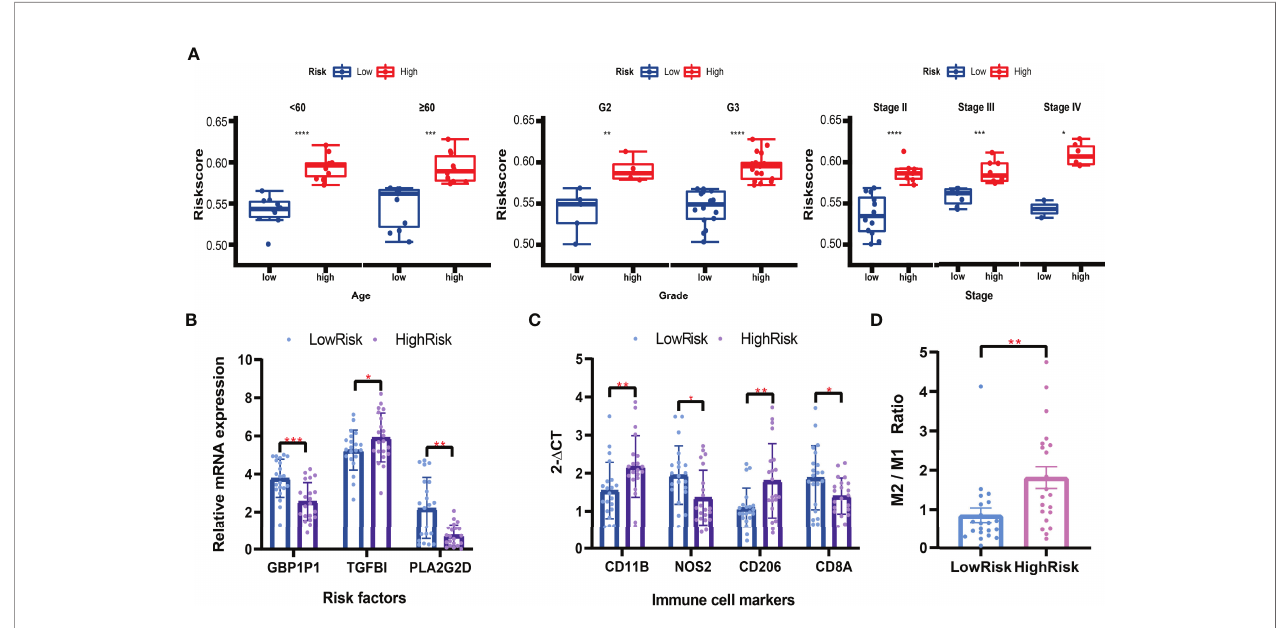
FIGURE 11 | Validation in clinical tissues by qRT-PCR. (A) Boxplots of the risk scores in subgroups (Aged ≥ 60, Age < 60, Grade 2, Grade 3, Stage II, Stage III, and Stage IV). Student ’ s t-test. (B) Relative mRNA expression levels (2 - D CT ) of risk factors included in the risk model. (C) Relative mRNA expression levels (2 - D CT ) of immune cell markers. (D) The M2/M1 ratio in the high-risk and low-risk patients. Mann-Whitney U test. * P < 0.05; ** P < 0.01; *** P < 0.001; **** P <